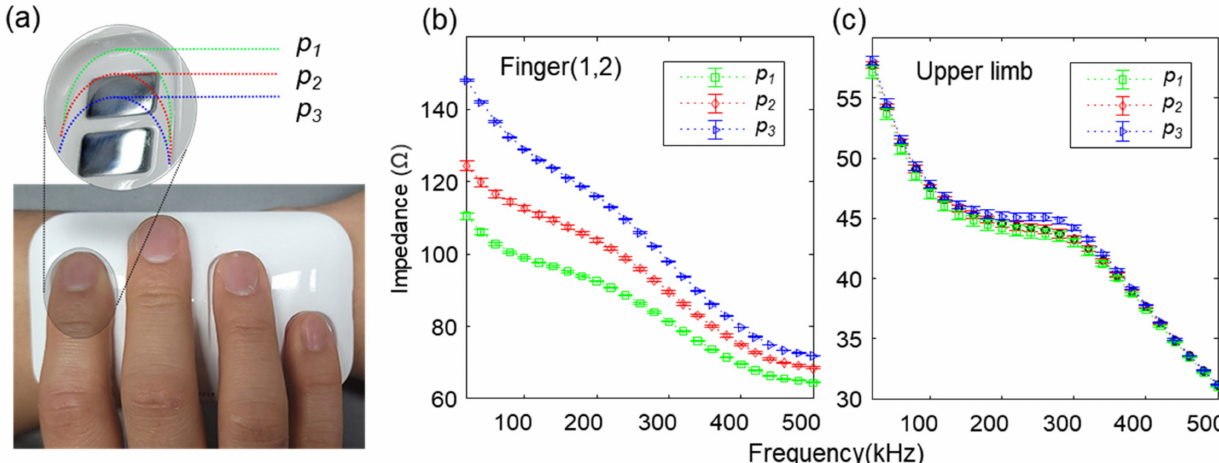
Figure 5. Impedance variation of finger and upper limb according to finger placement changes on the electrode. ( a ) Changes in the contact position ( P 1 ~P 3 ) of the subject’s index finger. ( b ) Variation of finger impedance according to the three electrode contact positions. ( c ) Variation of upper limb impedance according to the three electrode contact positions. The data are presented as mean ± standard deviation ( n =